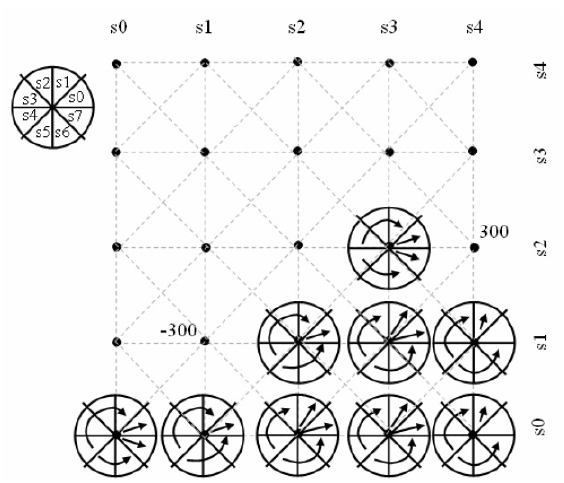
Figure 9. Resulting policy on an discrete topological map for rotating